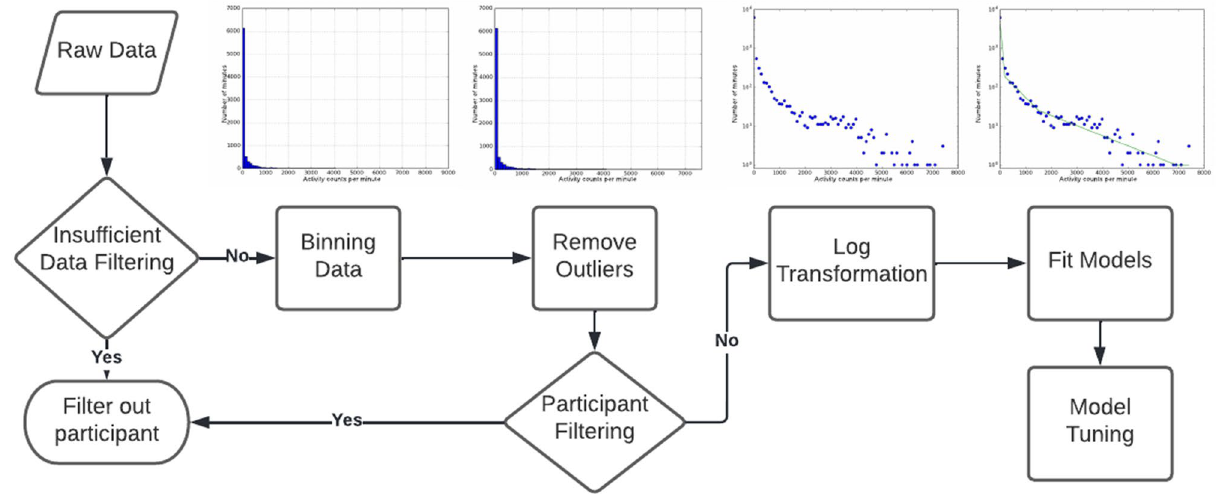
Figure 4. The process in which a participant is modelled. The plots above some stages in the process help visualize what a given participant’s data may look like at that particular stage.